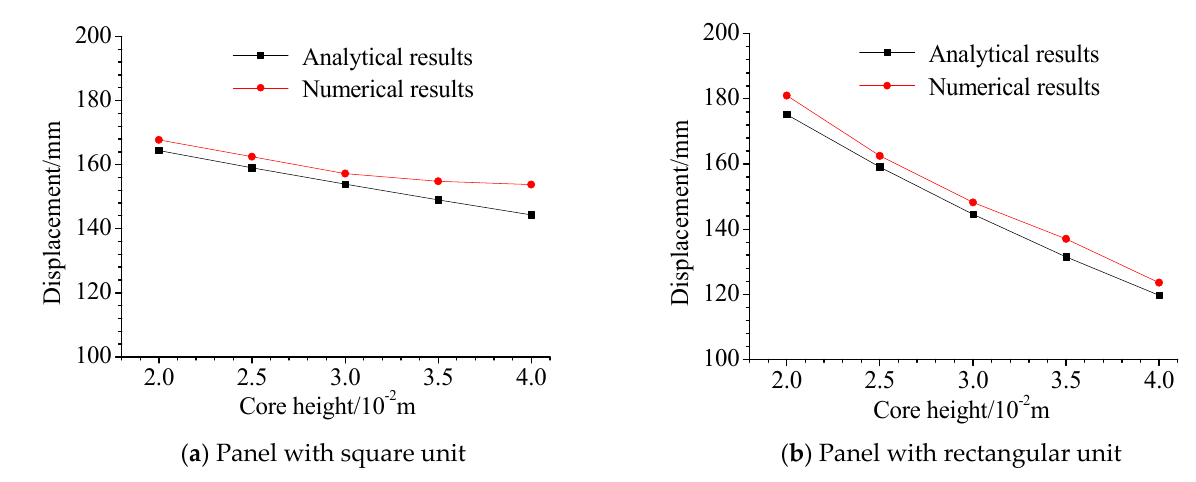
Figure 11. Displacement curves of the I ‐ type sandwich panel with different core heights.